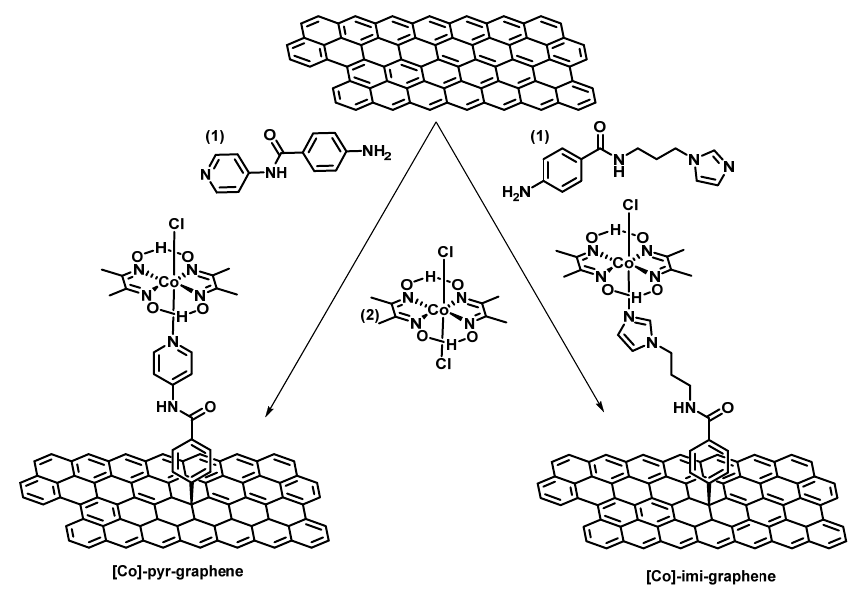
Figure 1. Preparation of [Co]-pyr-graphene and [Co]-imi-graphene materials.